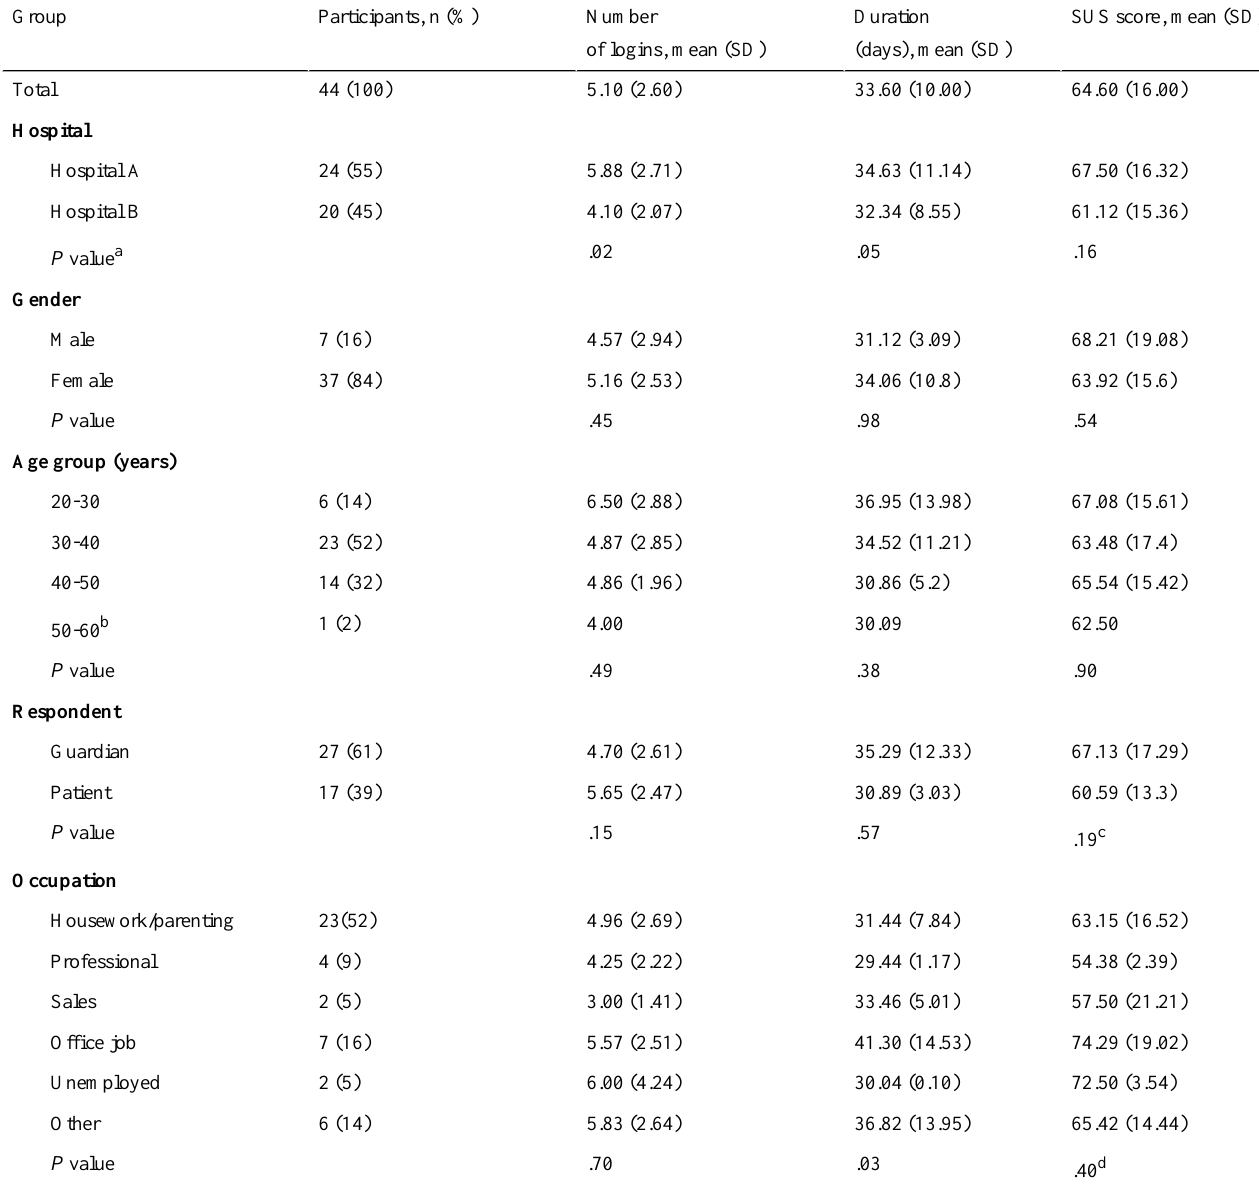
Table 3. Usage patterns and System Usability Scale (SUS) scores of app